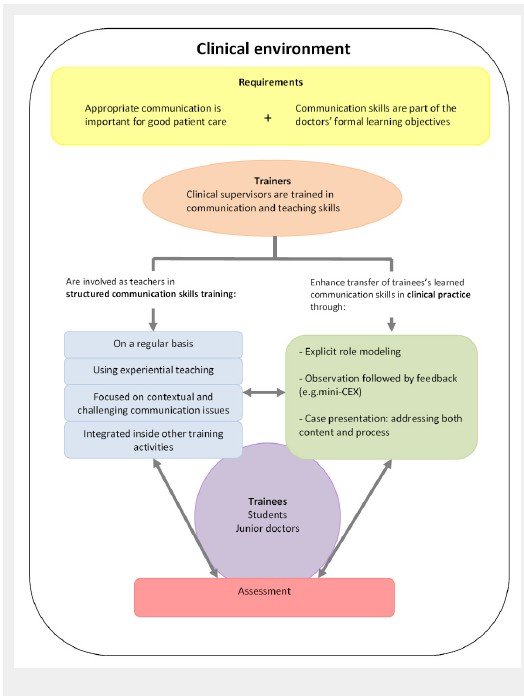
Dynamic model of communication skills training and teaching in the clinical